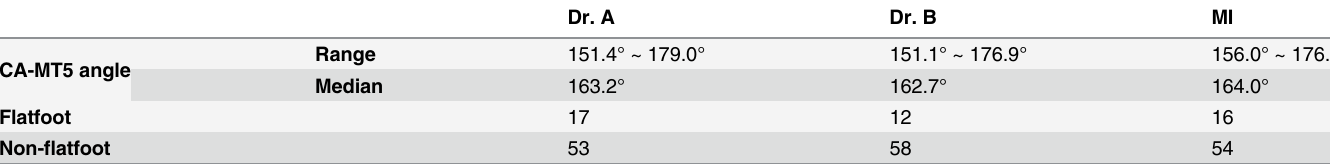
Table 1. Comparison of the CA-MT5 angle measurements obtained by radiologists A and B and using the MI registration